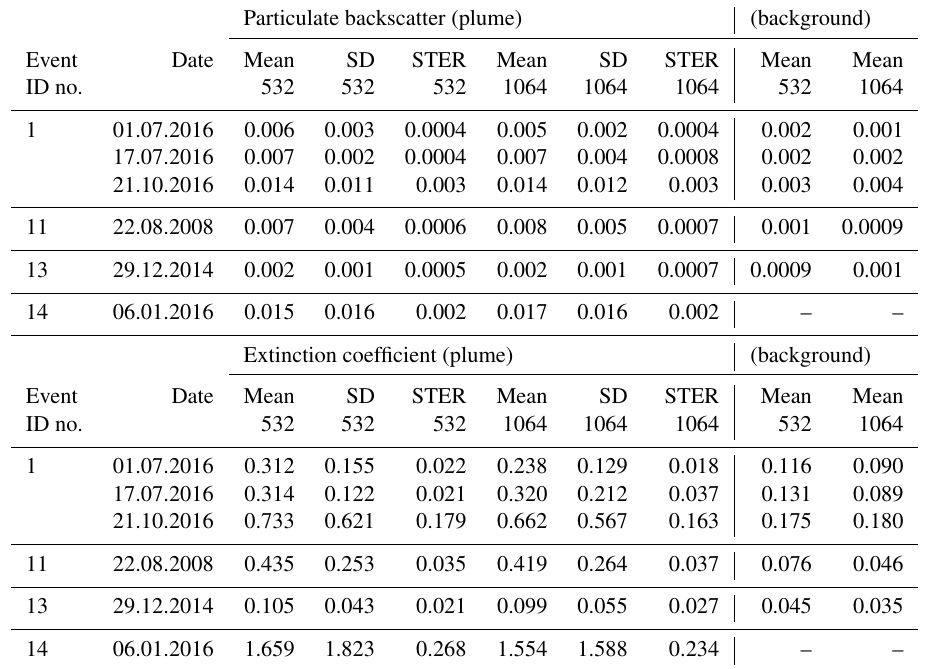
Table 5. Backscatter and extinction statistics for plume values based on CALIPSO lidar measurements.